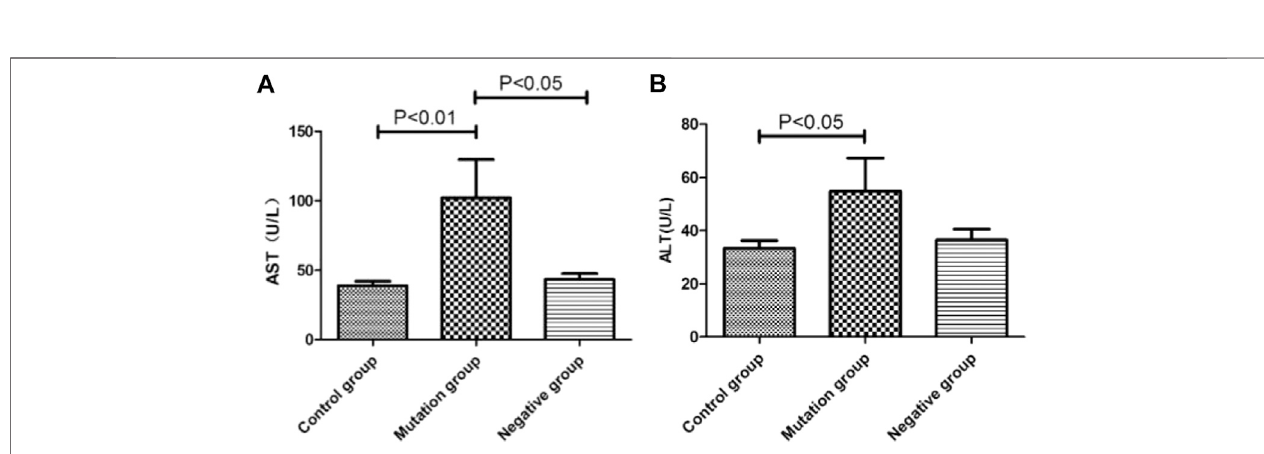
FIGURE5| ThelevelofALTandASTindifferentYMDDmutationalmotifandcontrolgroups. A.B: Biochemicalparameters ofALT (B) andAST (A) associatedwith/ without YMDD mutations in different groups.